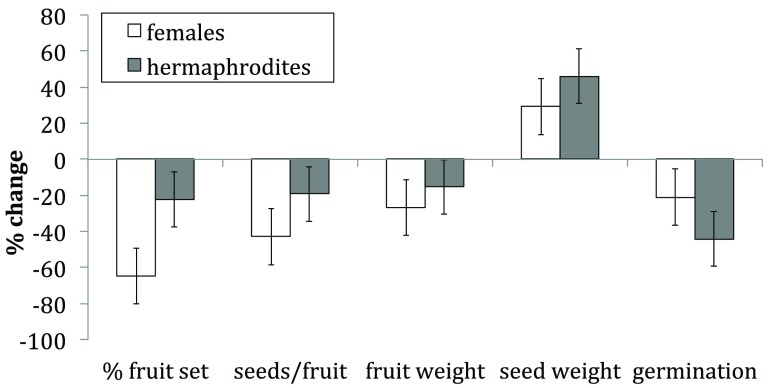
Percent change of female (white) and hermaphrodite (grey) reproductive output measures between current and reduced pollination regimes (p < 0.05).± 1 standard error bars shown.